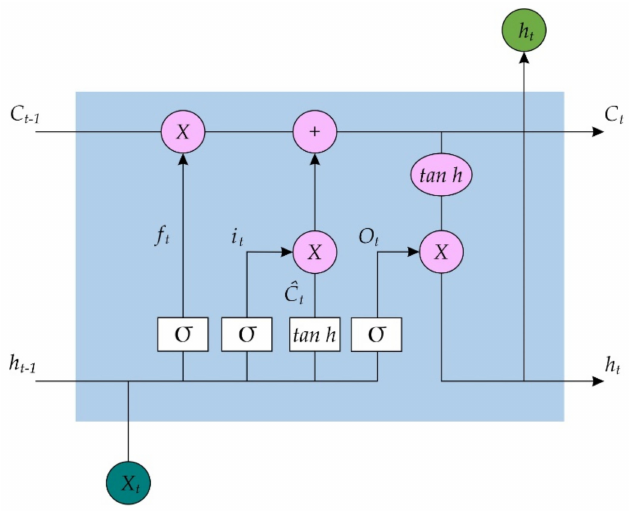
Figure 5. The structure of a Long Short-term Memory cell (according to: